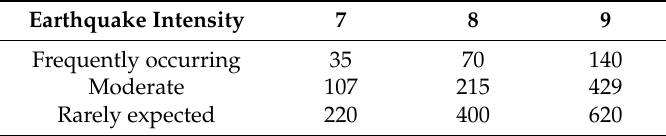
Table 7. A (cid:48) max /Gal of seismic waves.